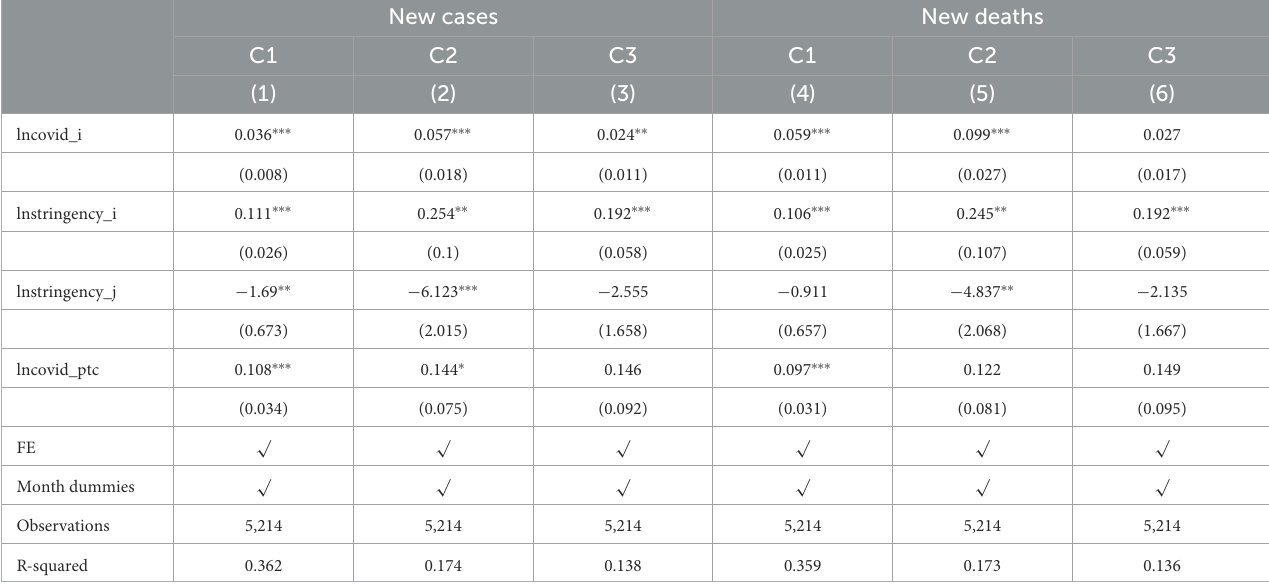
TABLE 5 New death and new case regressions.